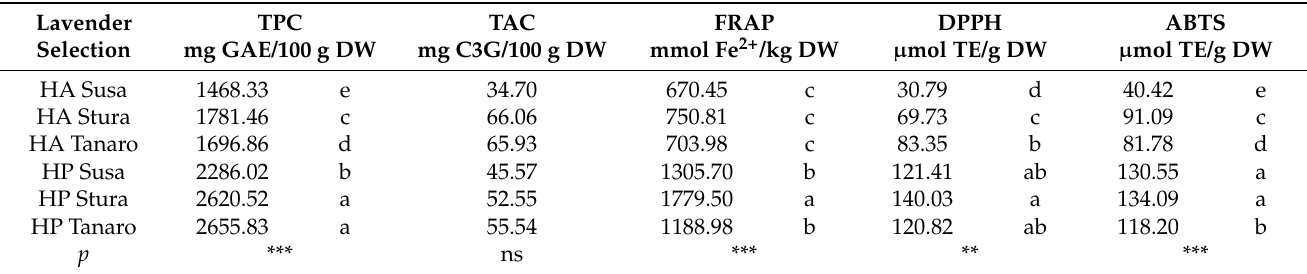
Table 3. Differences in total phenolic content (TPC), total anthocyanin content (TAC), and antioxidant activity (FRAP, DPPH, and ABTS assays) of L. angustifolia decoction according to the drying